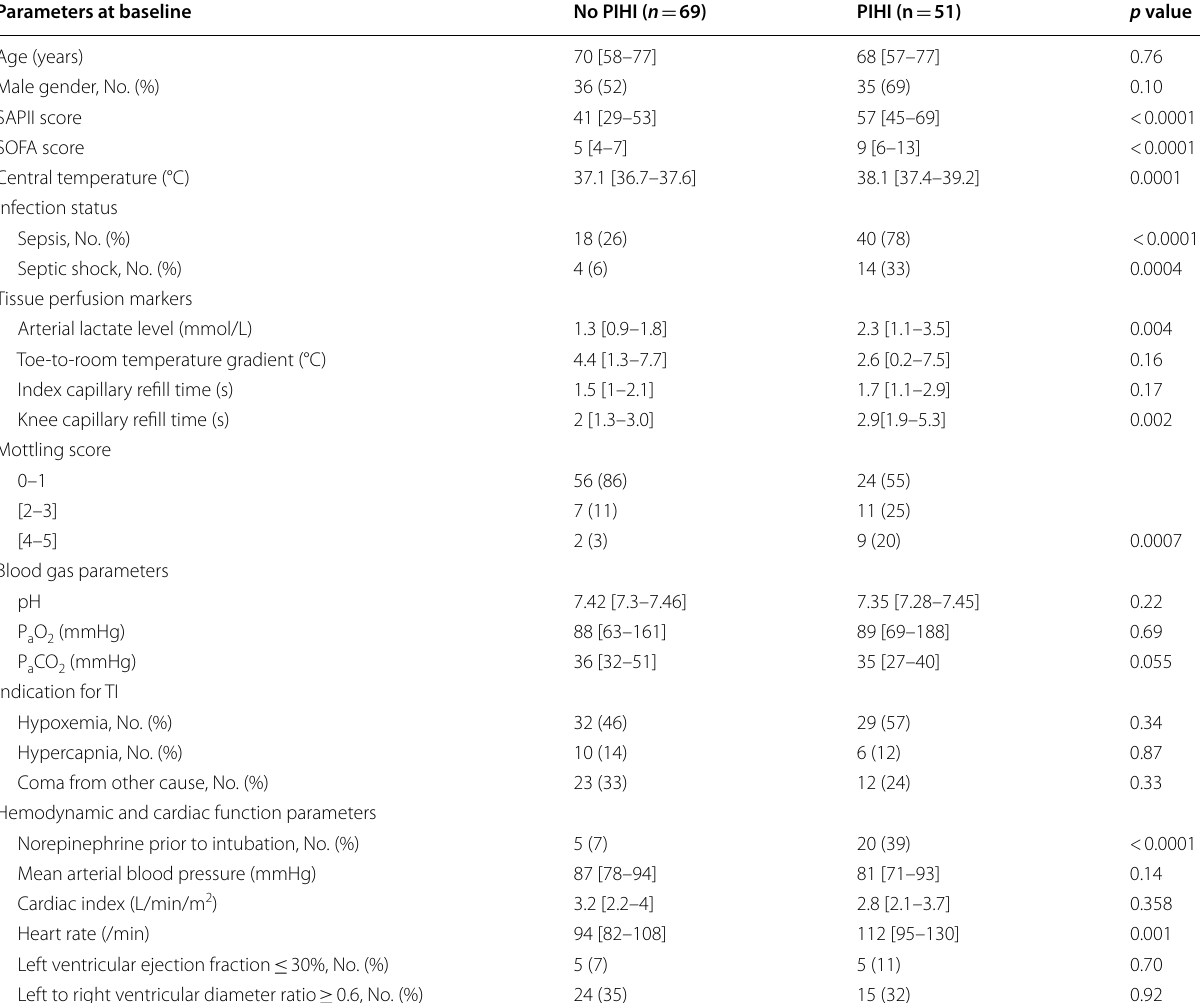
Parameters including baseline characteristics, global hemodynamic and tissue perfusion marker in patients with and without PIHI. Data are No. (%) of patients for discontinuous variables, and median [interquartile range] for continuous variables